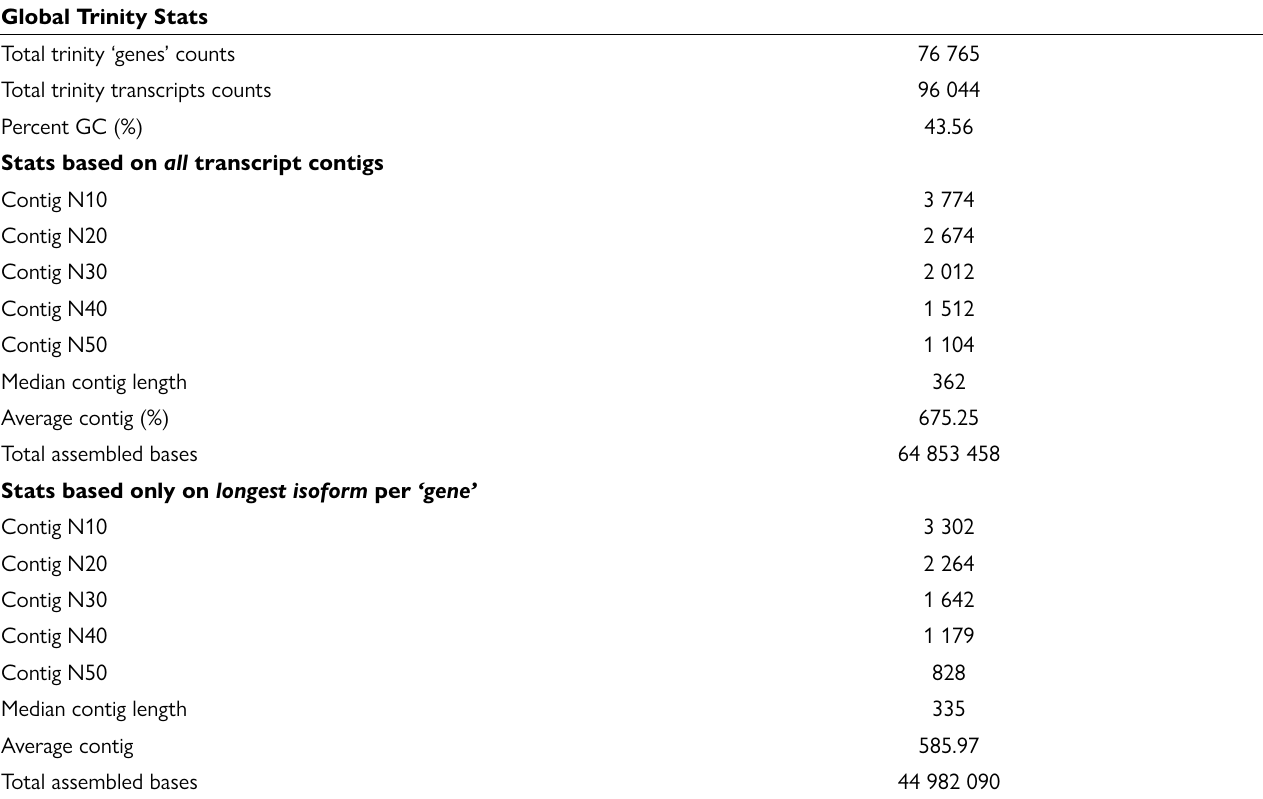
Table 1. Statistics of Trinity de novo assembly.